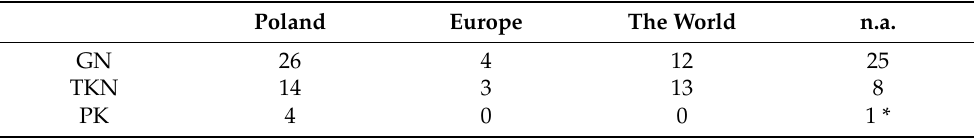
Table 10. Post topics—geographical aspect (N = 114). Each post could be assigned to more than one category—the results do not add up to 114.